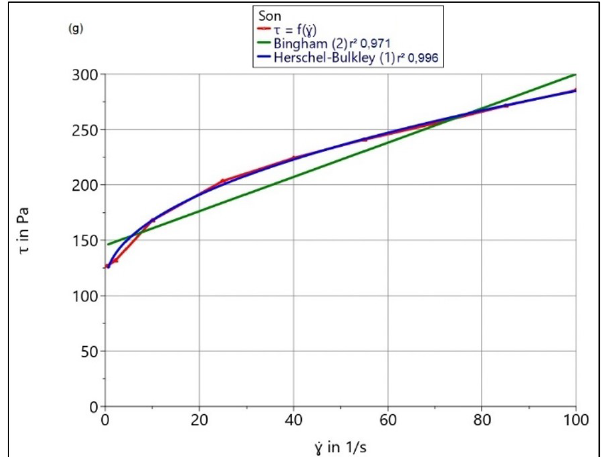
Figure 6. Rheological behavior curves of fresh Portland cement pastes fit with the Herschel-Bulkley and Bingham